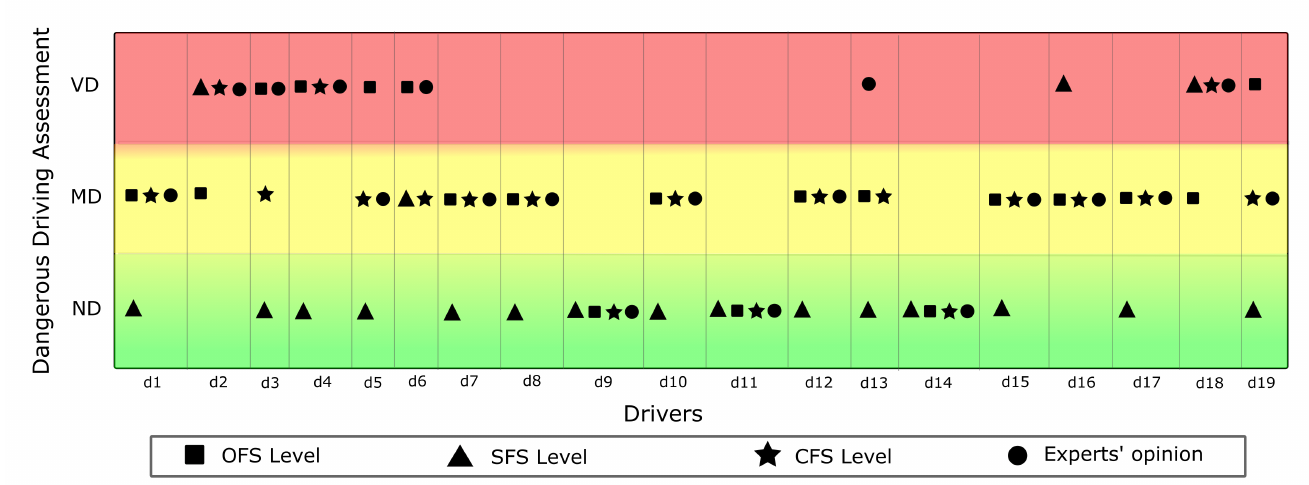
Figure 13. Comparisons against Expert opinion.